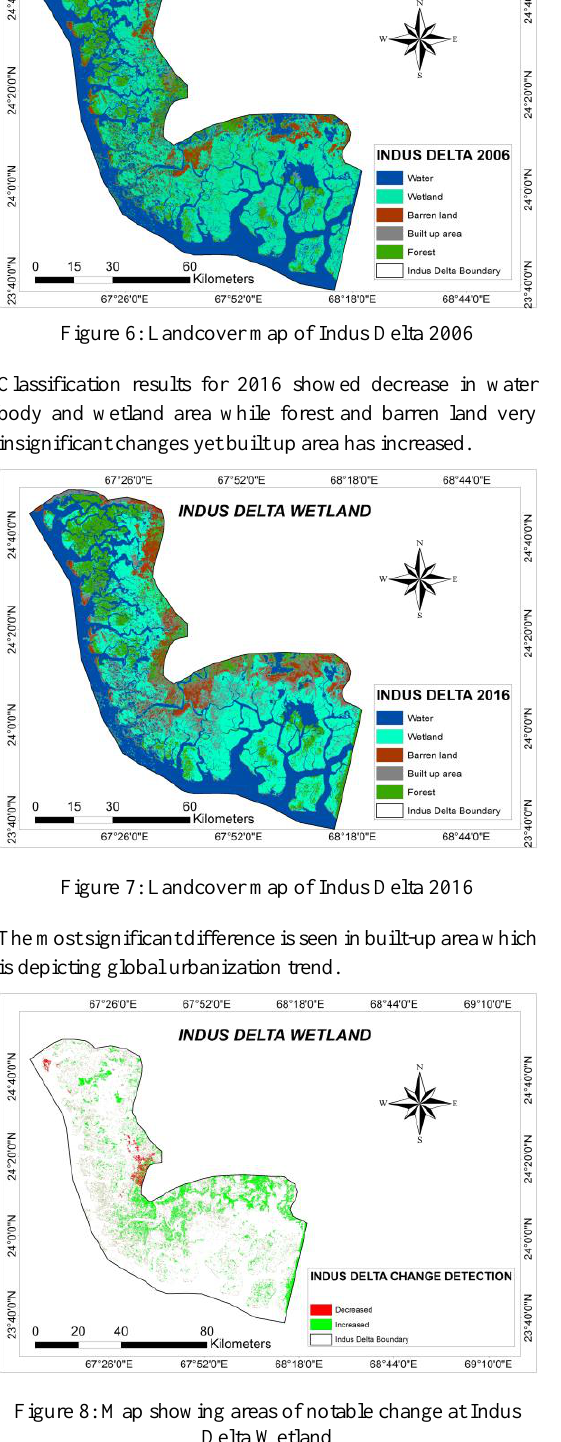
Figure 8: Map showing areas of notable change at Indus Delta Wetland